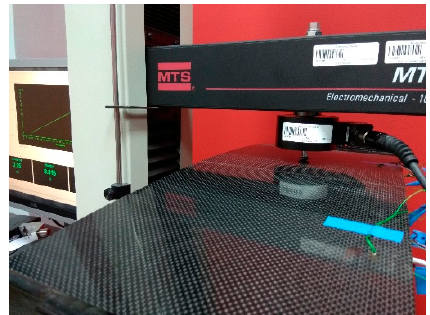
Figure 2. Experimental testing. Reprinted from [15].